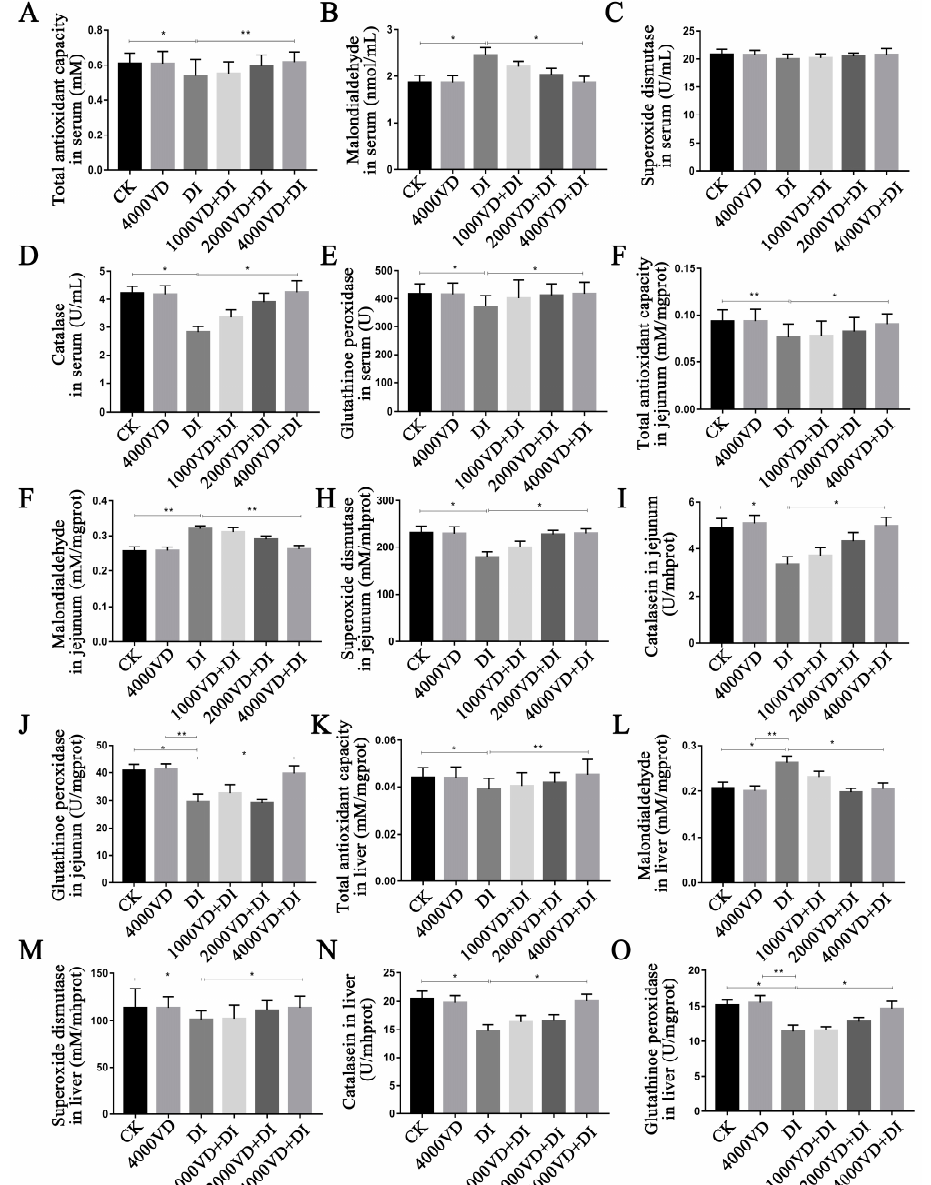
Figure 9. Effects of different supplemental levels of VD 3 on oxidation-related indexes of the Wenchang chicken oxidative stress model. ( A – E ): in serum. ( A ) T-AOC, ( B ) MDA content, ( C )